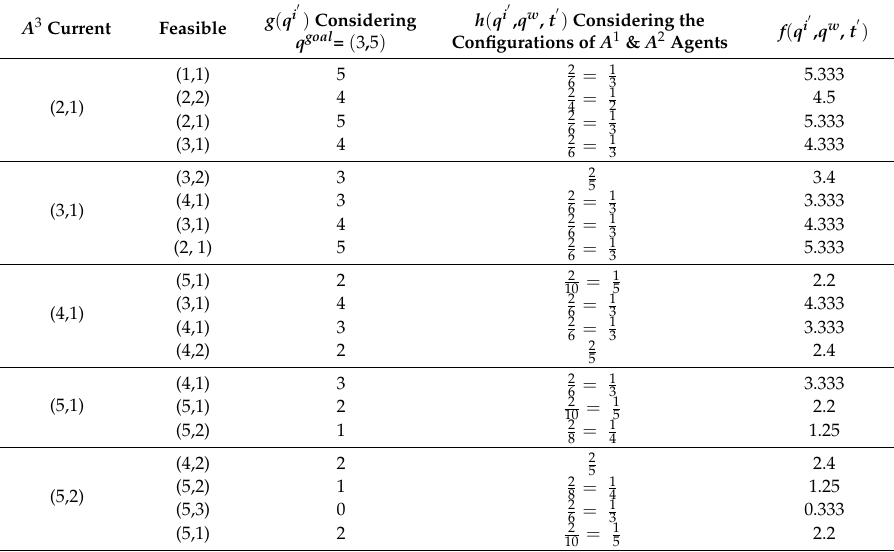
Table A1. Analytical Computations with the new heuristic